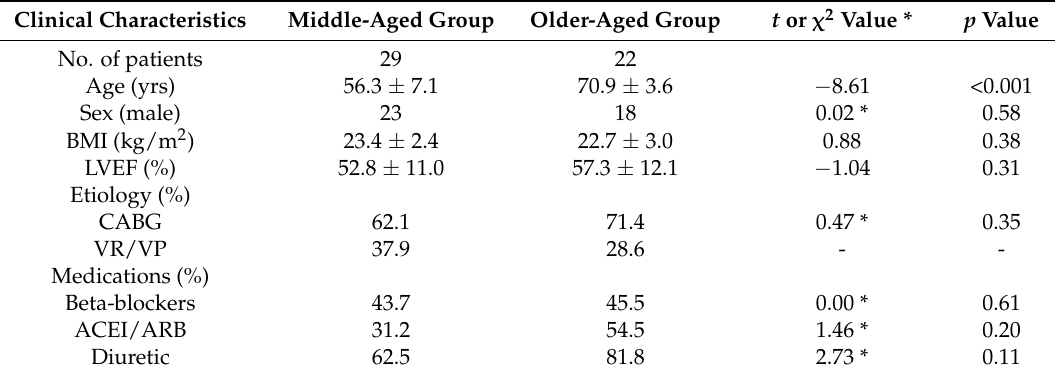
Table 1. Clinical characteristics of the